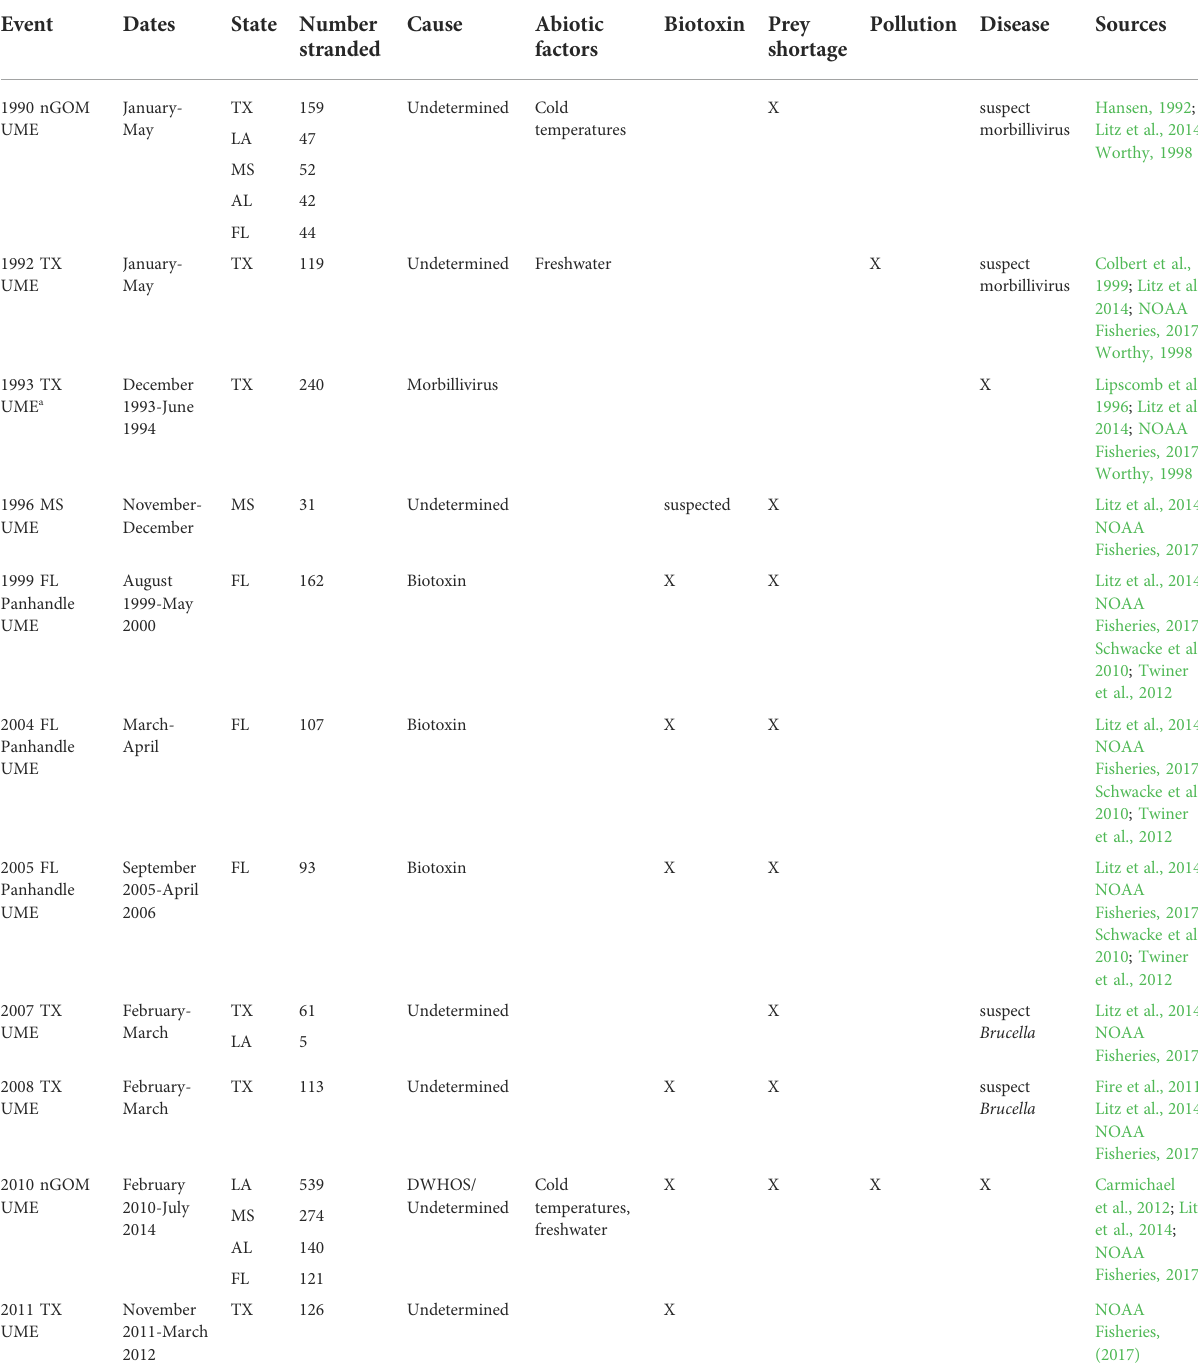
TABLE1Marinemammalstrandingoccurrencesdesignatedasunusualmortalityevents(UMEs)innGOMstatesthatoccurred1990 – 2016[Texas=TX, Louisiana = LA, Mississippi = MS, Alabama = AL, Florida panhandle (Escambia-Jefferson counties)] =